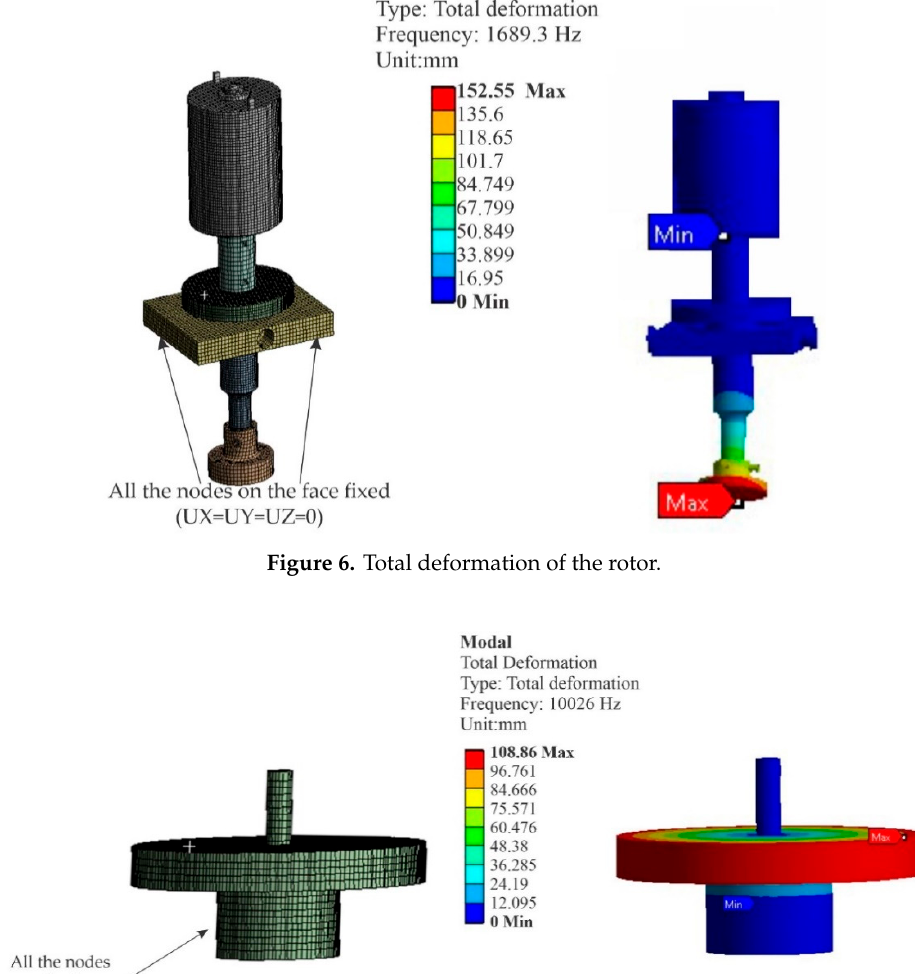
Figure 7. Total deformation of the inertia flywheel.